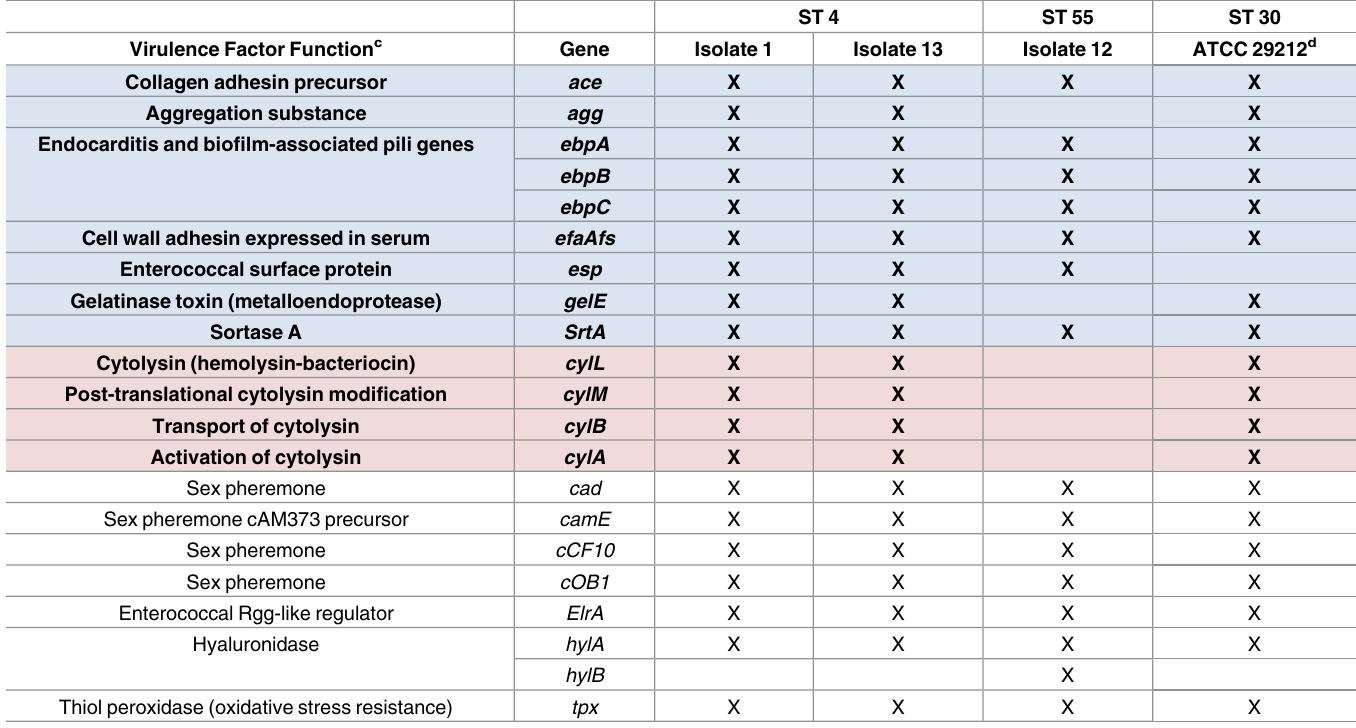
Table 7. Acquired Virulence Factor Genes Identified Using VirulenceFinder a and PATRIC b